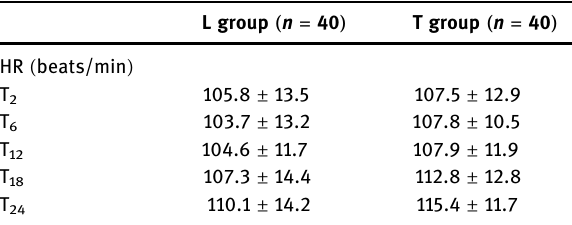
Table A2: Comparison of HR in the two groups within 24 h after operation L group ( n = 40 ) T group ( n = 40 ) HR ( beats/min